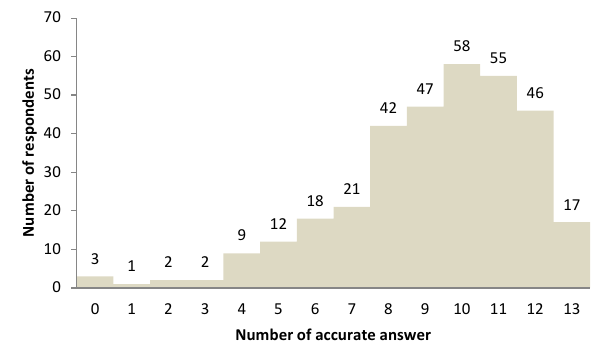
FIGURE 2 | Respondents’ knowledge level.